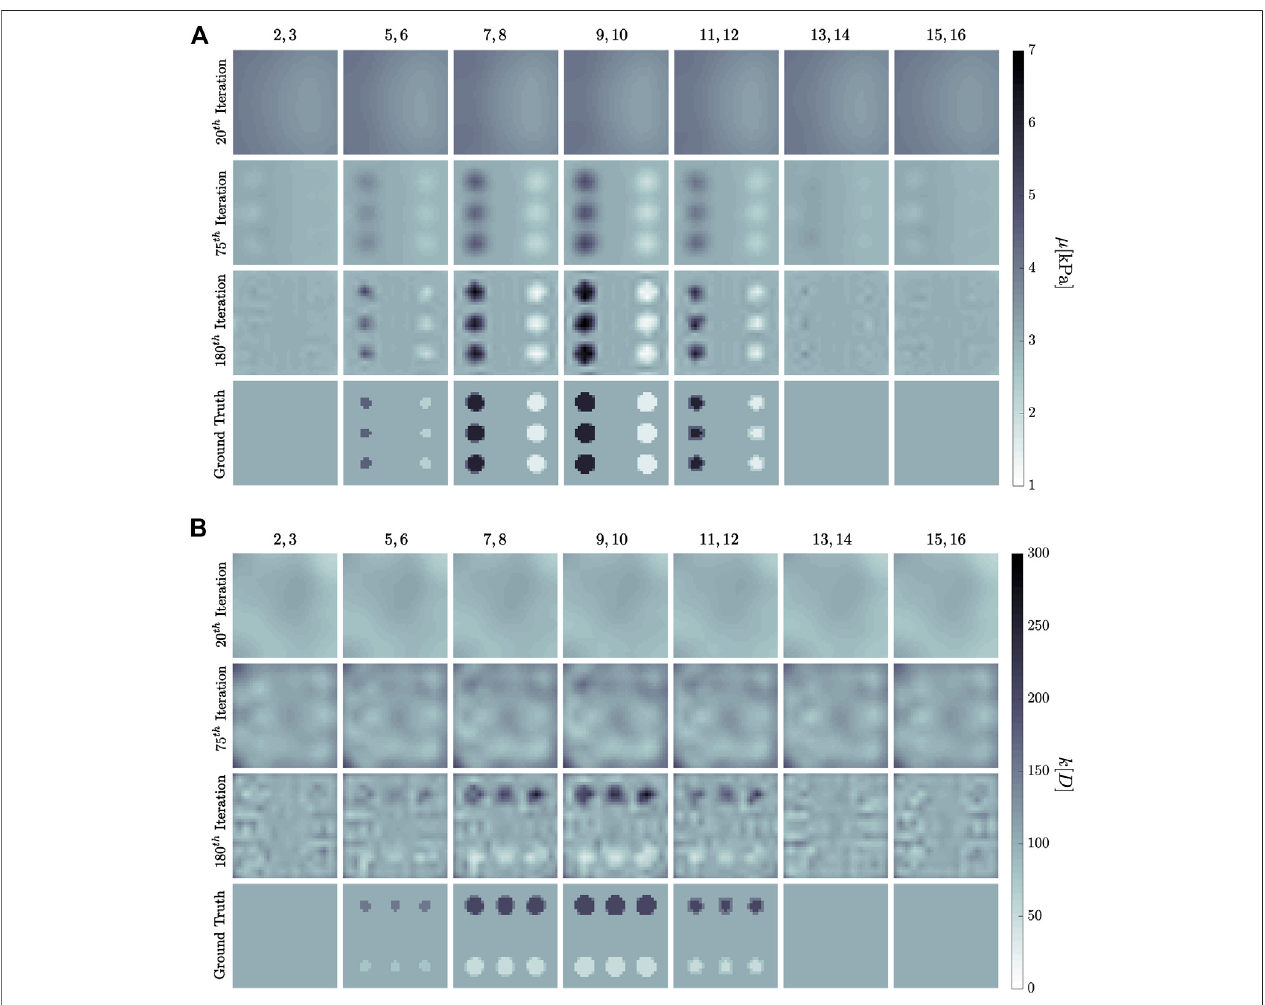
FIGURE 11 | Simultaneous inference evolution of both (A) shear modulus, μ , and (B) hydraulic permeability, k , in the 1 Hz experiment setup in Figure 10 . The former is measured in kilo-Pascal, while the latter in Darcy. Columns are averages of the numbered ( xy ) -planes as in the other simulations. Rows are labeled by which iteration they are in MRE i